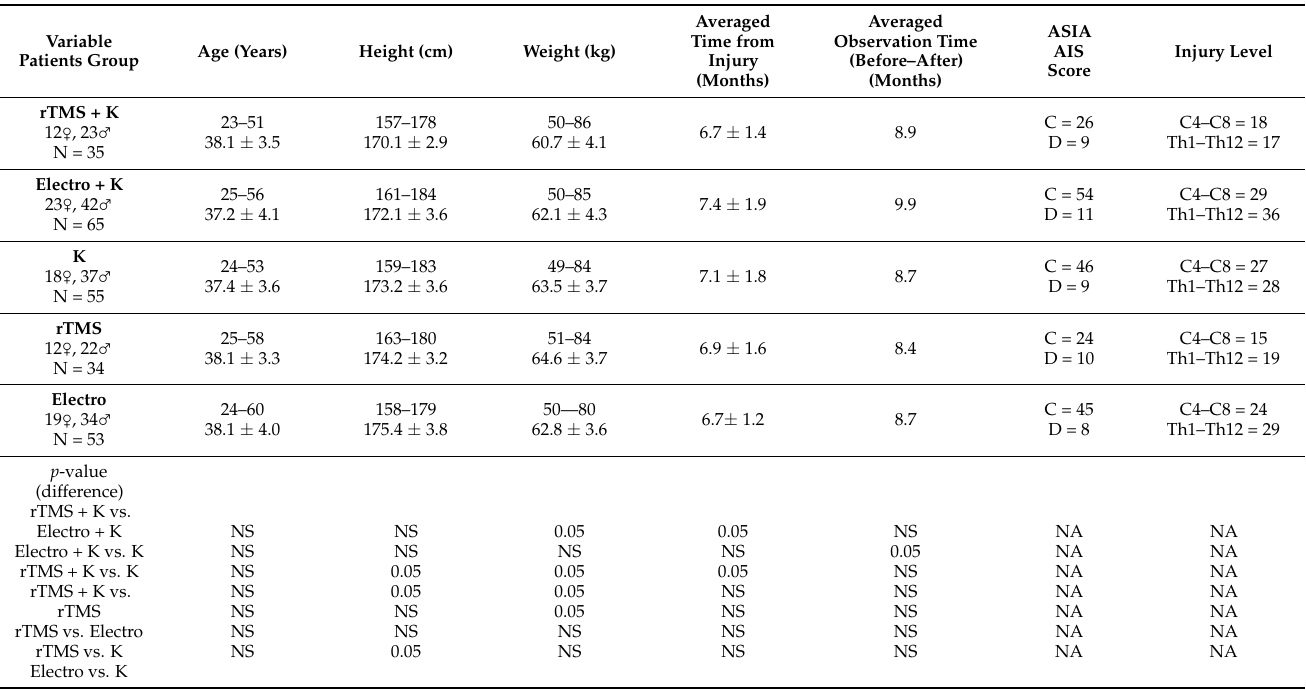
Table 1. Demographic, anthropometric, and traumas characteristics as well as the average duration of the applied therapies (before–after observation time) in the iSCI patients treated with different modalities. Minimum and maximum values, mean values, and standard deviations are